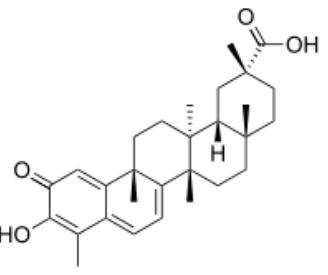
Figure 5. Chemical structure of